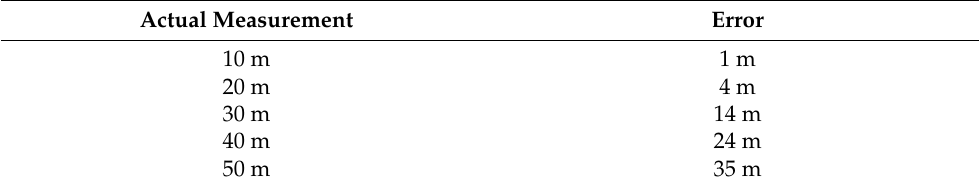
Table 2. Depth-extraction-value error for underground utility tunnel distance obtained using DenseDepth.